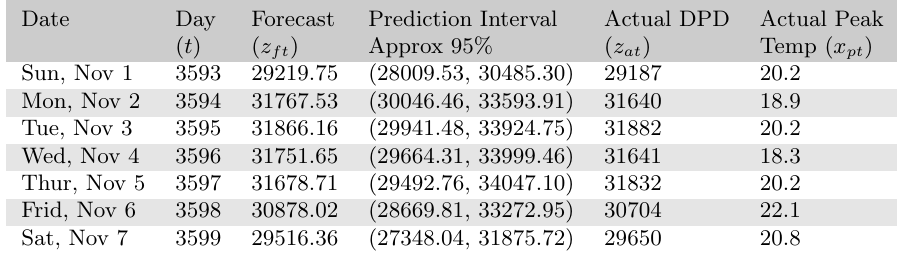
Table 4: Forecast and Actual DPD for the first seven days of November